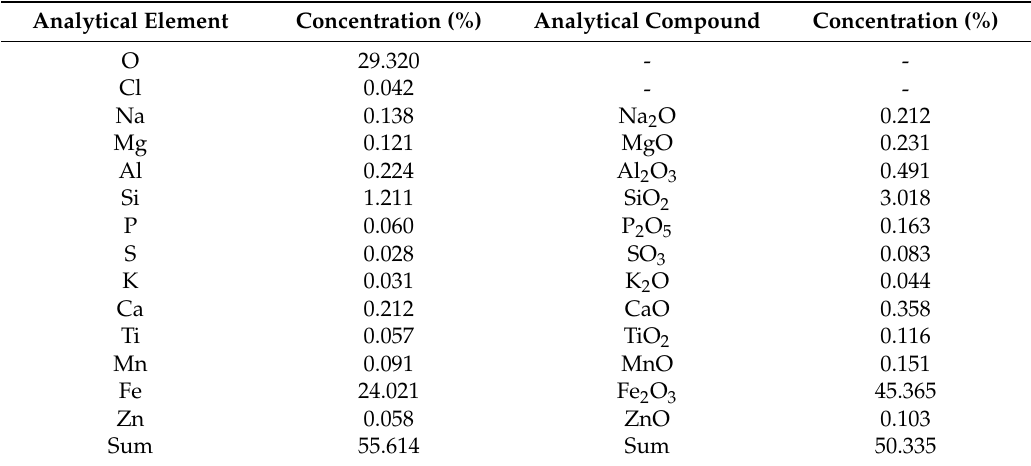
Table 1. The analysis result of XRF.